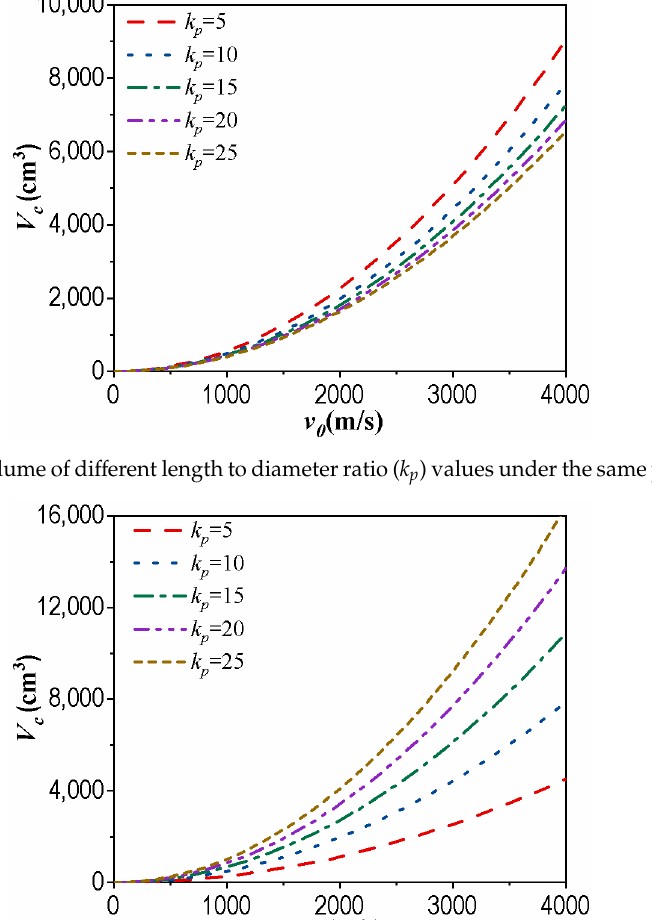
Figure 19. Crater volume of different k p values under the same projectile diameter.